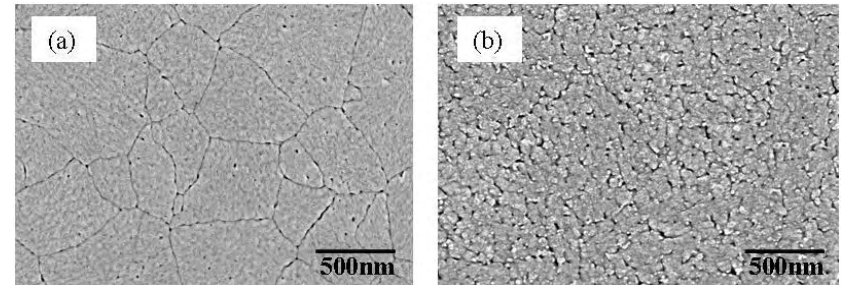
Figure 8. SEM micrographs showing deposition sequence of NiO:150nm WO , (b) NiO on both sides of WO beneath WO 3